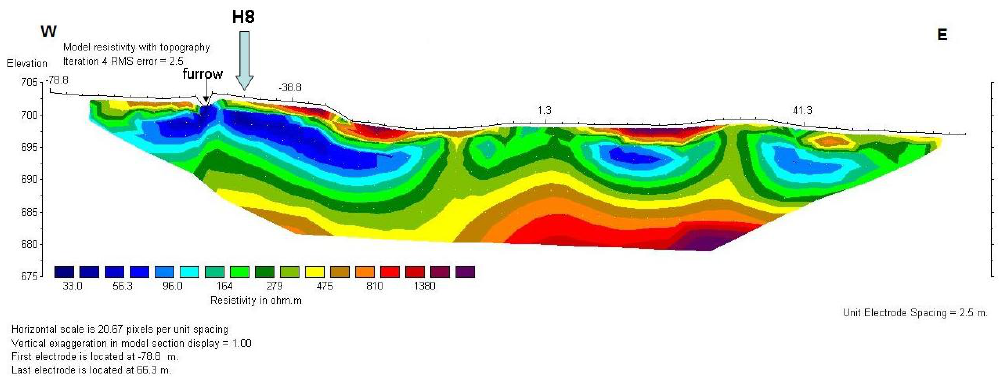
Fig. 4. Longitudinal ERI pseudosection of a transect along erosion gully. (Wenner long). NB. This survey was conducted prior to the installation of hydrometric apparatus.